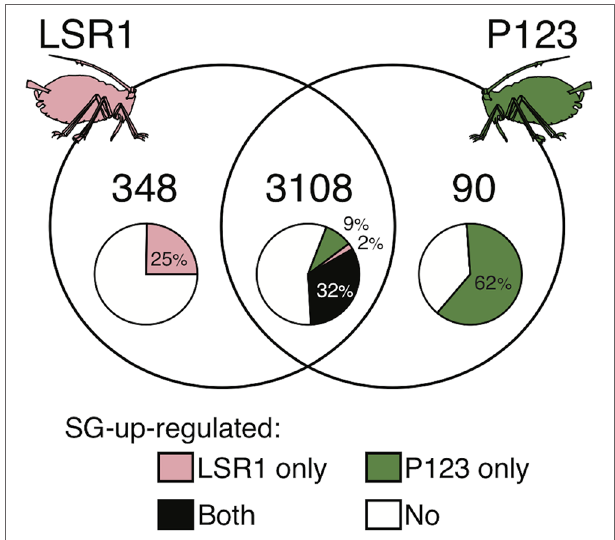
FIGURE 2 | Candidate salivary effectors identified from salivary gland transcriptomes of LSR1 and P123 lines. Among the 3,546 candidate salivary effectors, 3,108 genes were expressed in both lines, 348 genes were expressed only in LSR1 and 90 genes were expressed only in P123. The pie charts indicate the proportions of salivary effectors that are upregulated in the salivary glands in comparison with the alimentary tract.